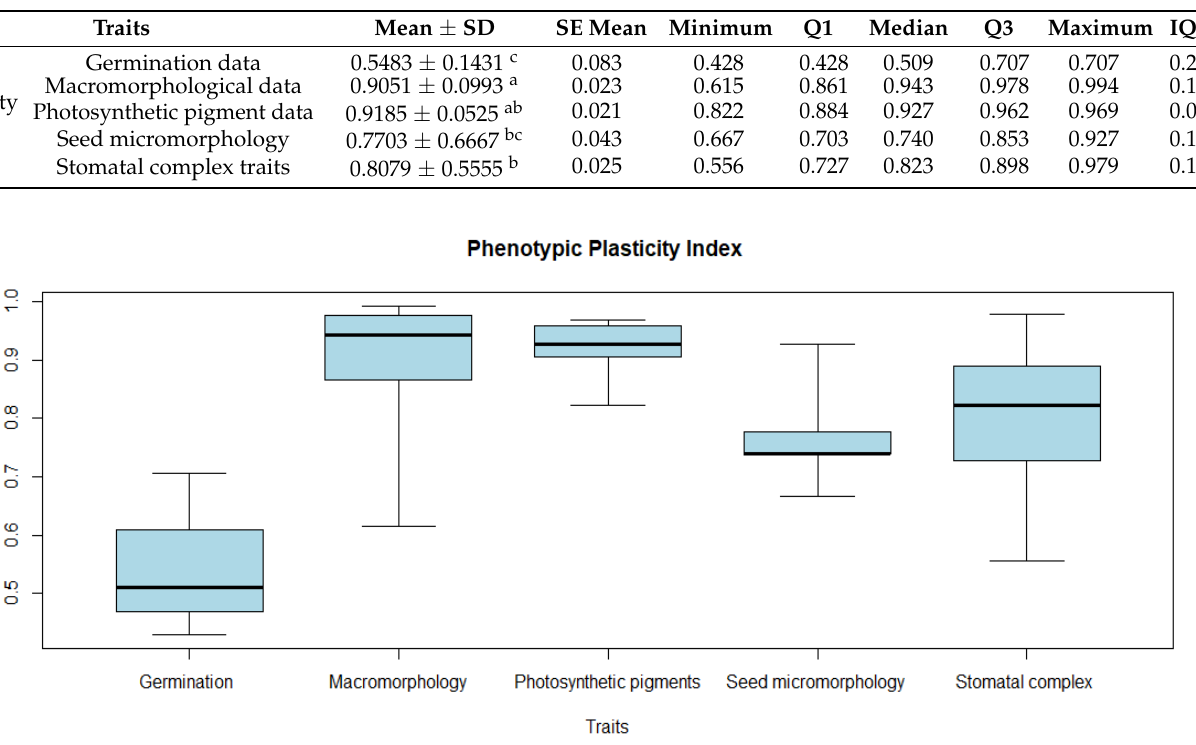
Table 5. Descriptive statistics of the plasticity index (PI) for the studied traits, showing pairwise comparisons among the three groups of Trianthema portulacastrum . Groups that share same letters are non-significant while different letters represent significantly different groups.